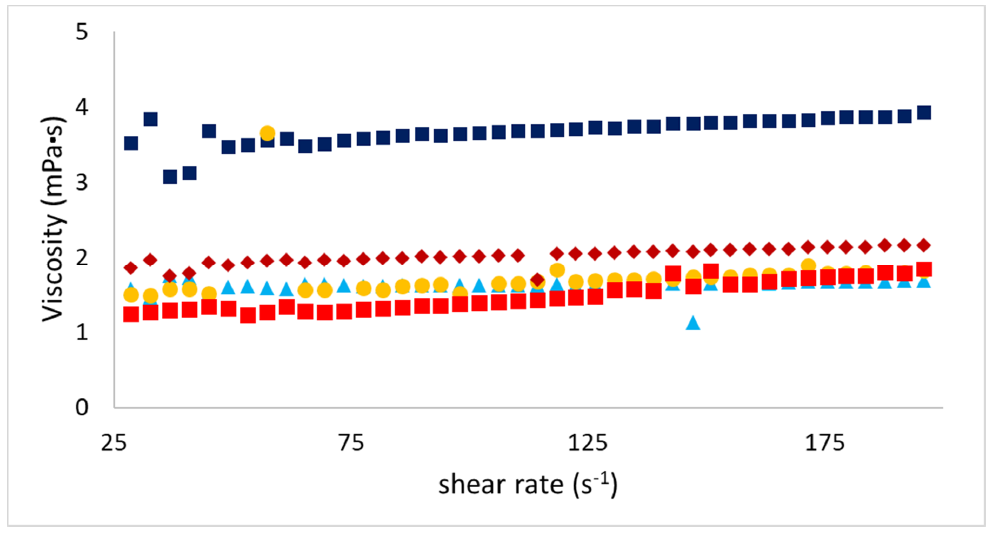
Figure 5. Viscosity (mPa·s) as a function of shear rate (s −1 ) for emulsions A ( ■ ), B ( ▲ ), C (●), D ( ■ ), and E ( ♦ ) (T = 19 °C). A and B were obtained from Sigma and Norland, and C, D, and E from different extraction protocols. Error bars are included in the points.